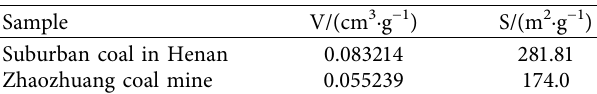
Figure 8: The specific surface area distribution curve of carbon dioxide adsorption coals. Table 1: Numerical values of pore volume and specific surface area of coal samples